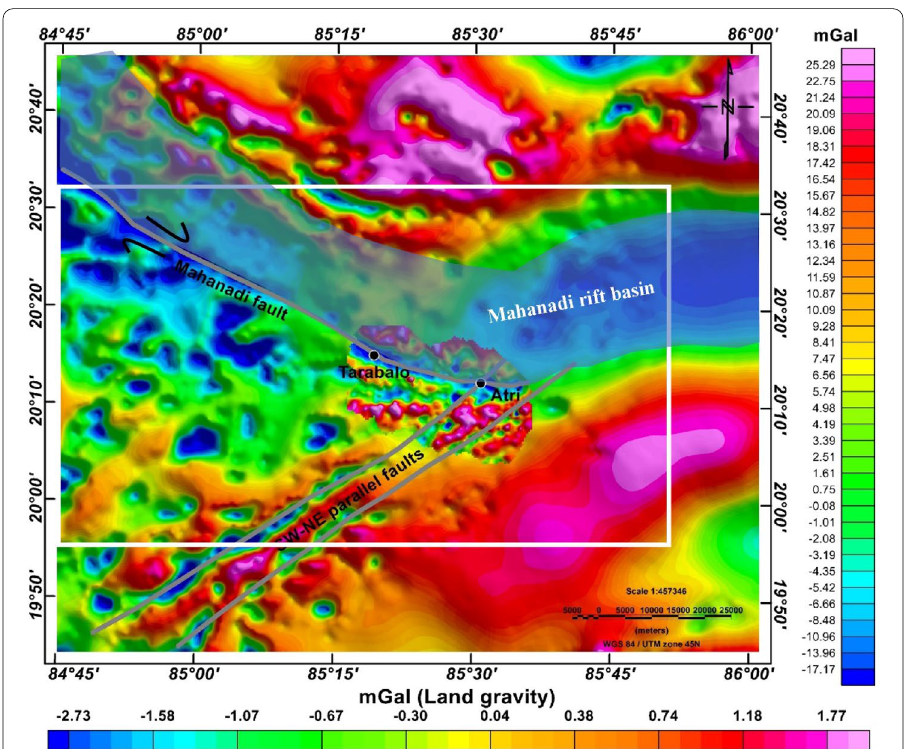
Fig. 10 Interpreted Bouguer anomaly map of the wider region along the Mahanadi rift basin overlaid by residual Bouguer anomaly map (Fig. 3c) of the surveyed area. Grey lines indicate the location of faults in the region while the white square represents the outline of the area covered by the Geology map (Fig. 1) and the shaded portion indicates the Mahanadi rift